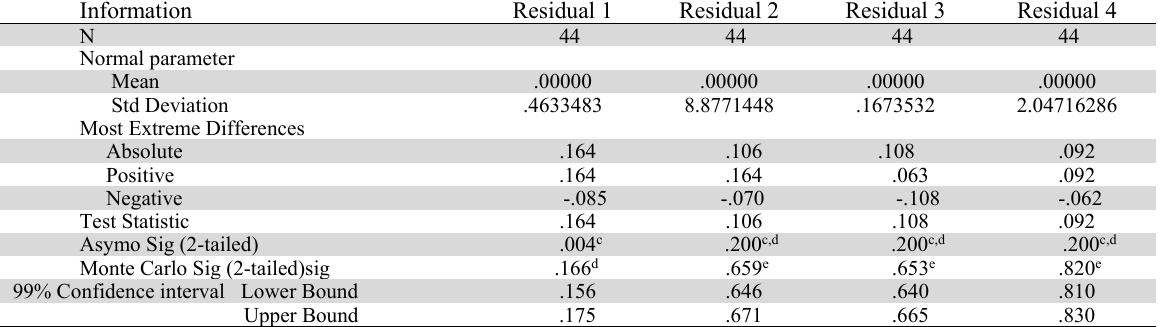
Normality Test Results of leverage, investment, and dividend equations